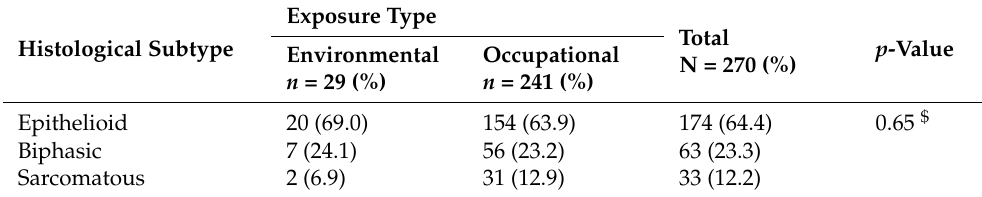
Table 4. Histological features of mesothelioma cases by exposure